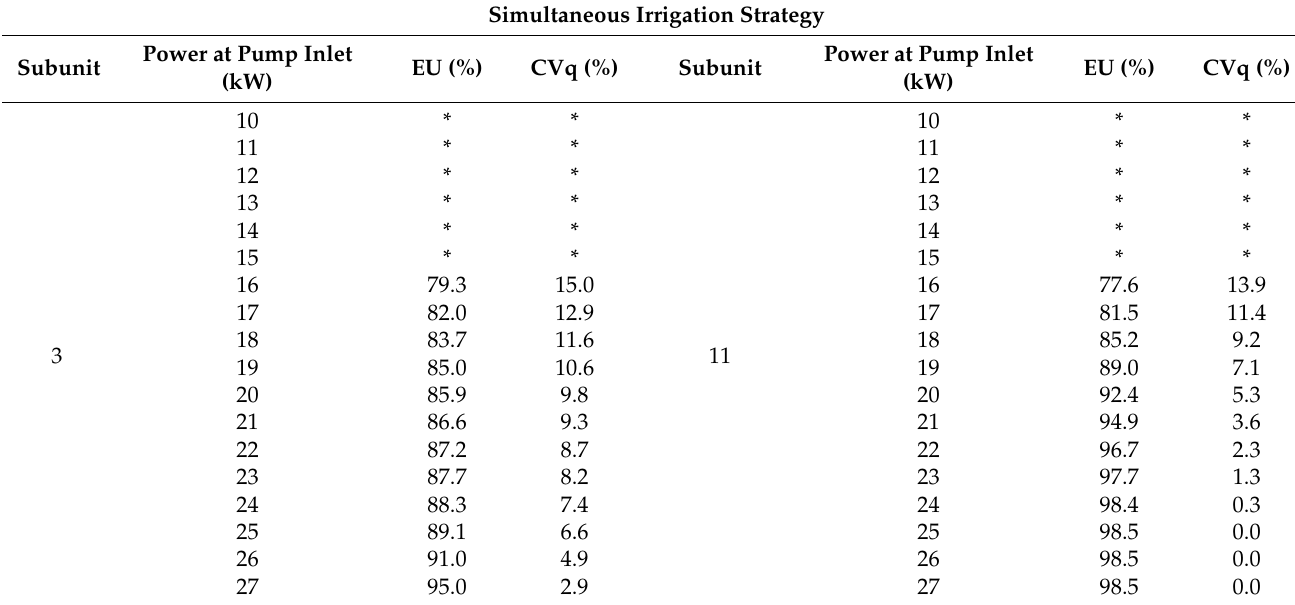
Table 3. Simultaneous irrigation strategy with several subunits.